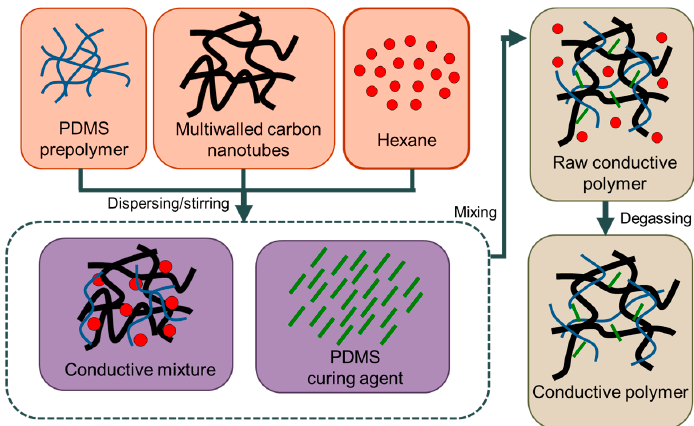
Figure 3. The preparation of conductive prepolymer used in the proposed sensor array.